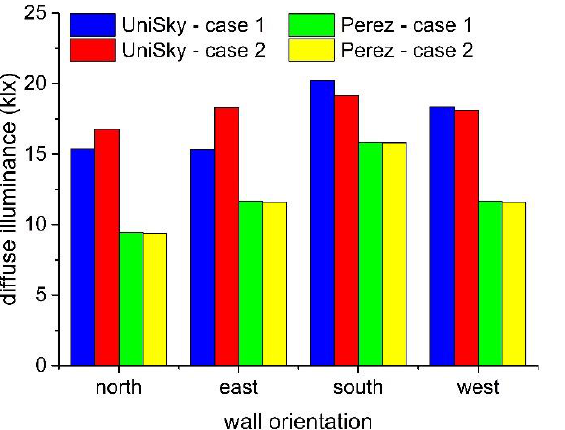
Figure 6. Diffuse illuminance on vertical walls calculated for the sky luminance patterns depicted in Figure 4.